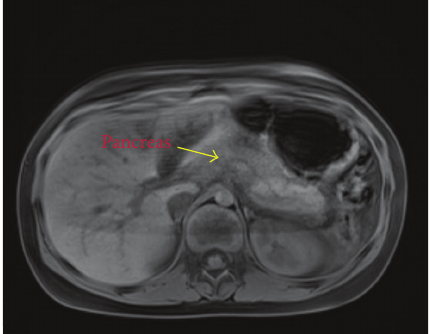
Figure 1: Well-circumcised mass over the head/neck of the pan- creas.